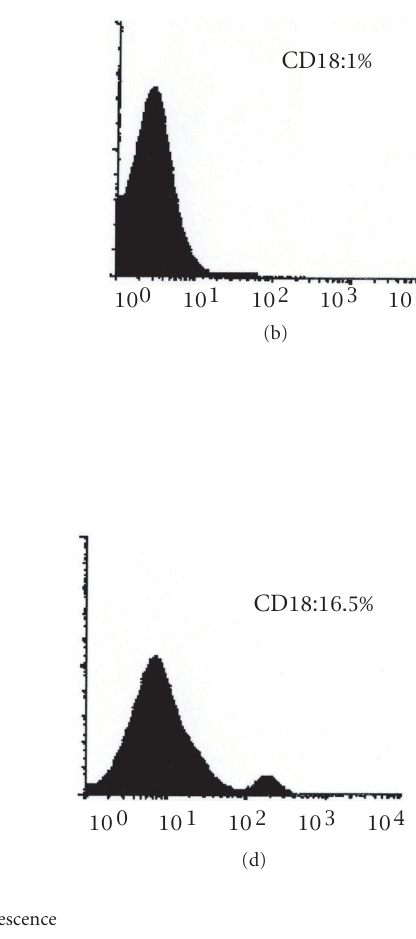
Figure 1: FACS analysis of the β 2 integrin CD18 expression at the surface of PBMCs from Tunisian patients with leukocyte adhesion deficiency (LAD). (a) control from a non-affected individual. (b), (c) and (d) represent respectively, the CD18 expression pattern obtained in patients (I, S, R), M, and K.